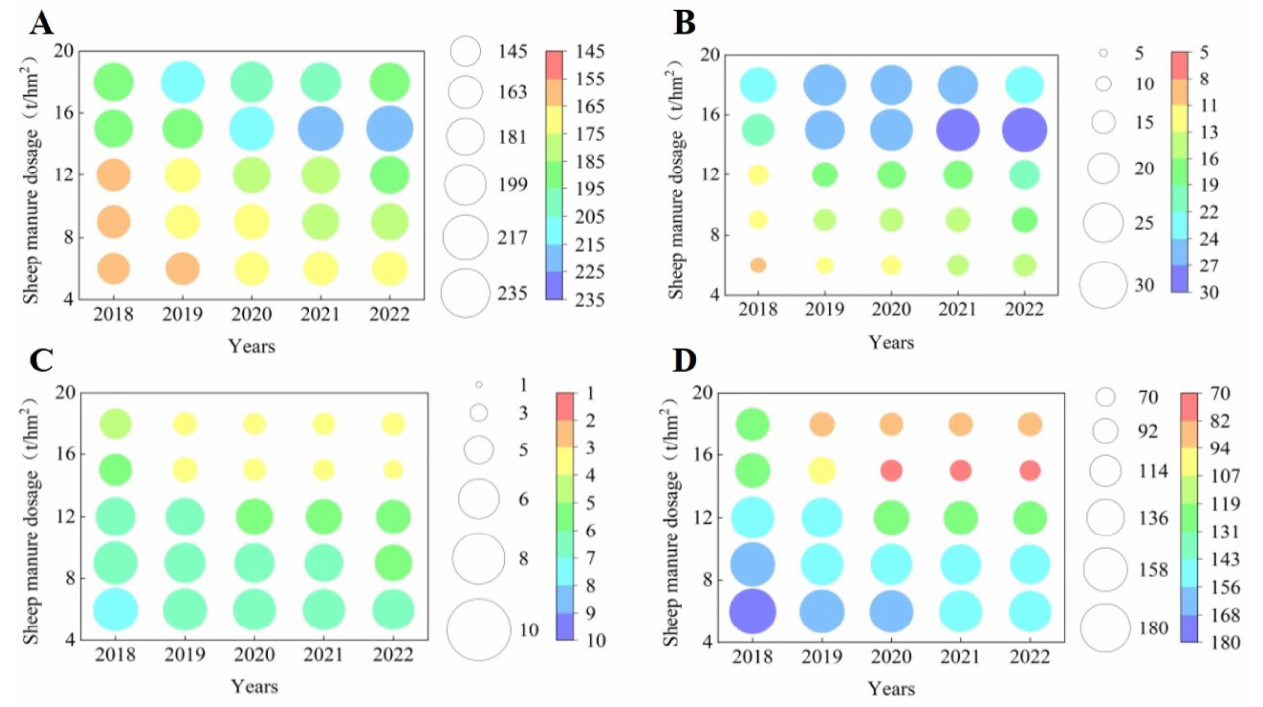
Figure 7. Effects of sheep manure fertilizer on soil enzyme activities in tea plantation. ( A ) Urease ( µ mol/min/L); ( B ) protease ( µ mol/min/L); ( C ) nitrate reductase ( µ mol/min/L); ( D ) nitrite reductase ( µ